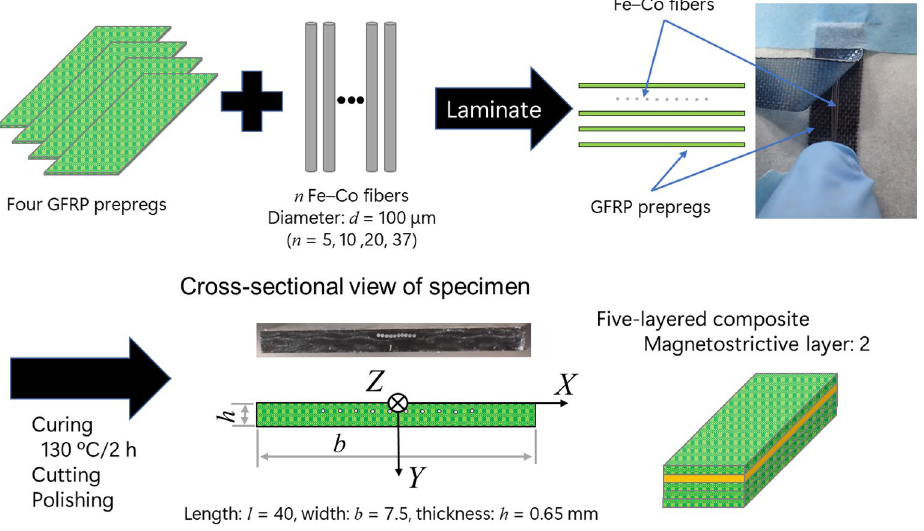
Figure 6. Specimen preparation’s